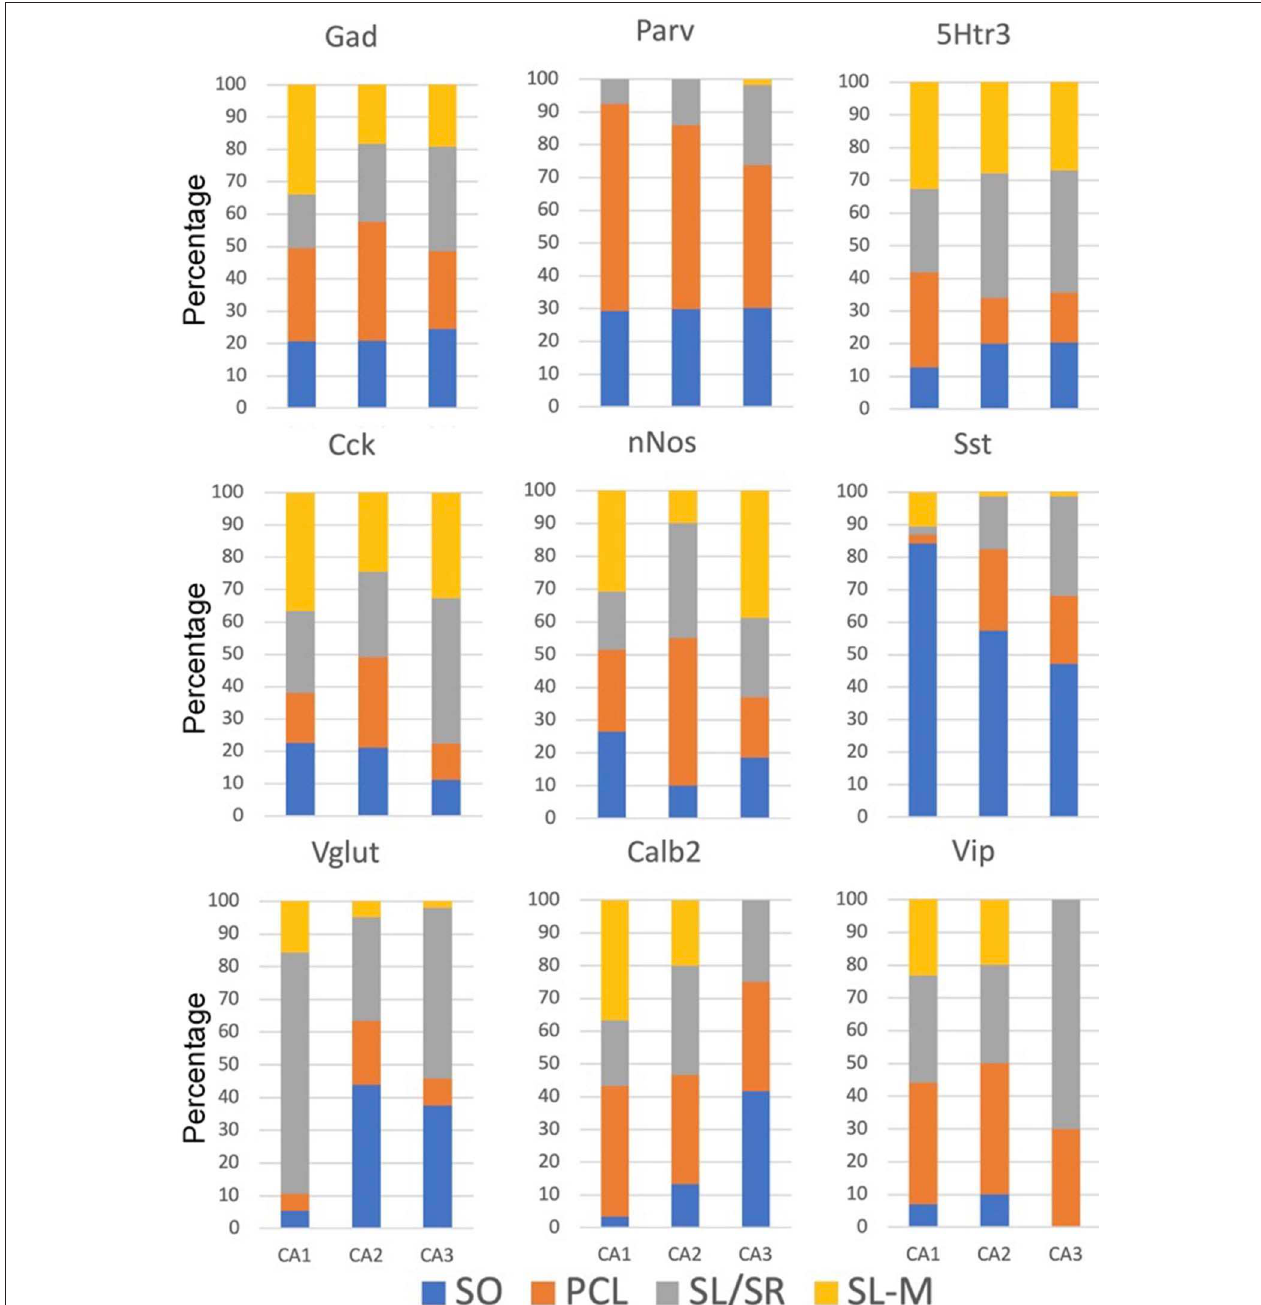
FIGURE 11 | Percentages of different interneurons in sublayers of the CA regions by marker. Cck neurons in the PCL of FC, CA2, and CA3 were counted if they co-expressed Gad-1. GCL, granule cell layer; ML, molecular layer; PCL, pyramidal cell layer; SL/SR, stratum lucidum/radiatum; SL-M, stratum lacunosum-moleculare; SO, stratum oriens; SR, stratum